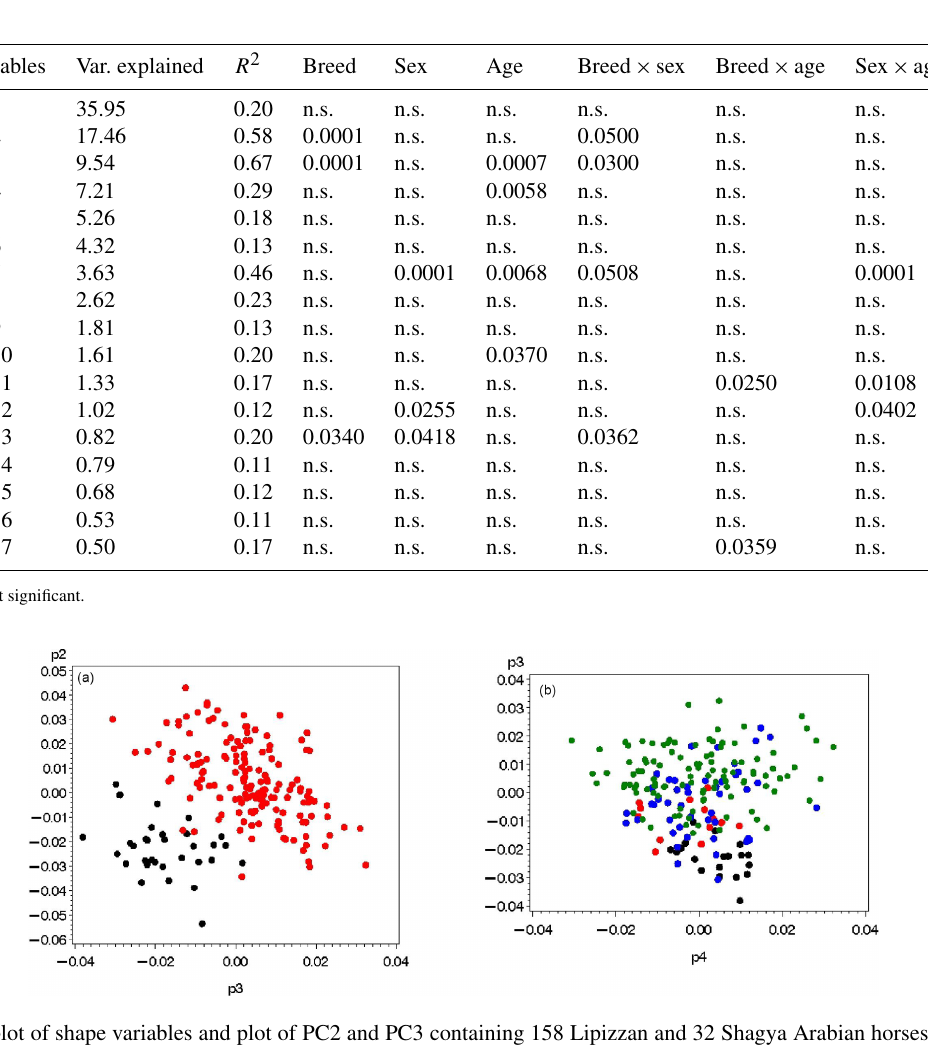
Table 2. Proportion of shape variance explained by PC (Var. explained); coefficient of determination of the linear model ( R 2 ); levels of significance for the fixed effects breed, sex, and age and for the interactions of breed and sex, breed and age, and sex and age from the linear model.